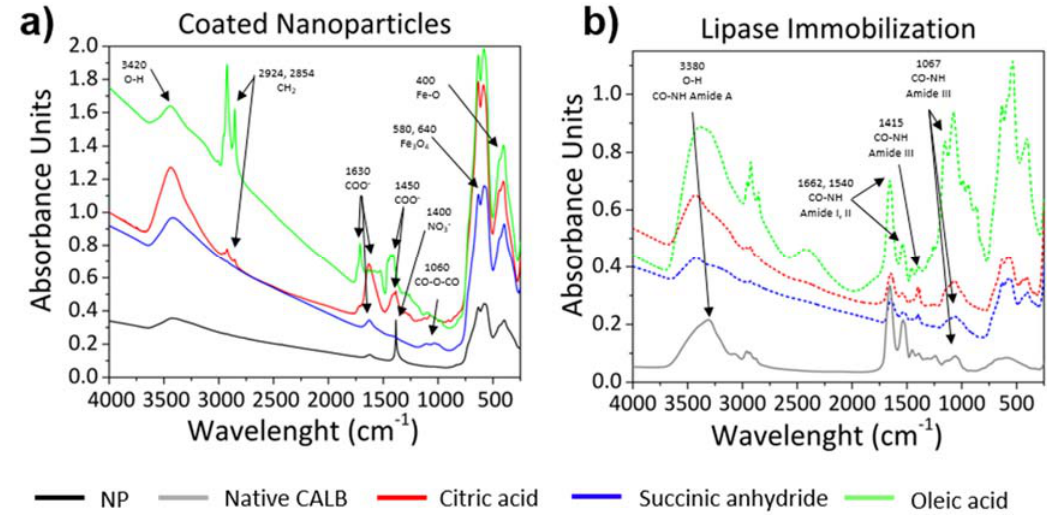
Figure 3. Fourier transform infrared spectra (FTIR) spectra of ( a ) CA, SA and OA coated NPs compared with the naked one and of ( b ) CALB EDA @CA-NPs, CALB EDA @SA-NPs and CALB EDA @OA- NPs.